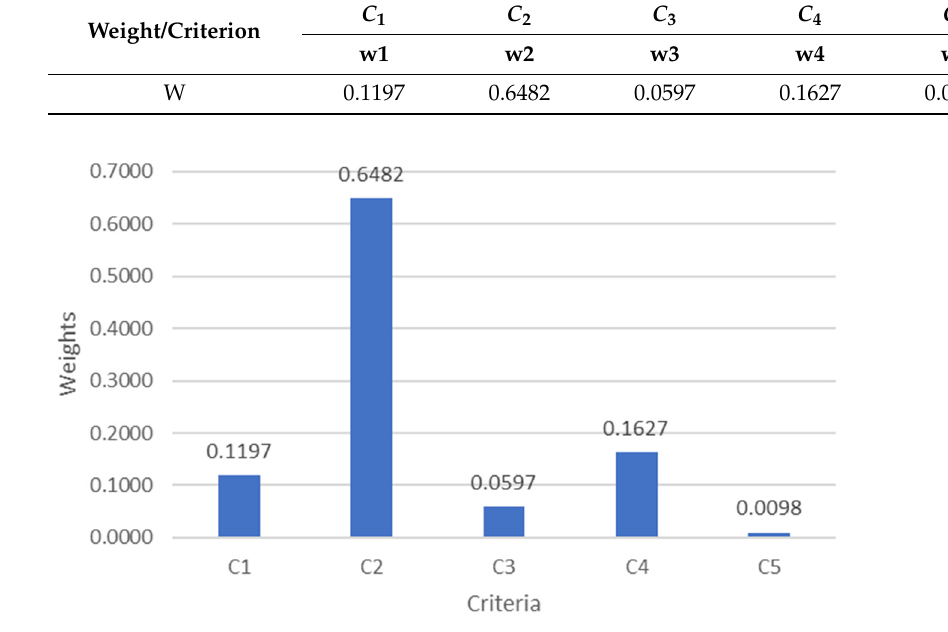
Figure 2. Obtained weights of criteria with Shannon’s entropy method.